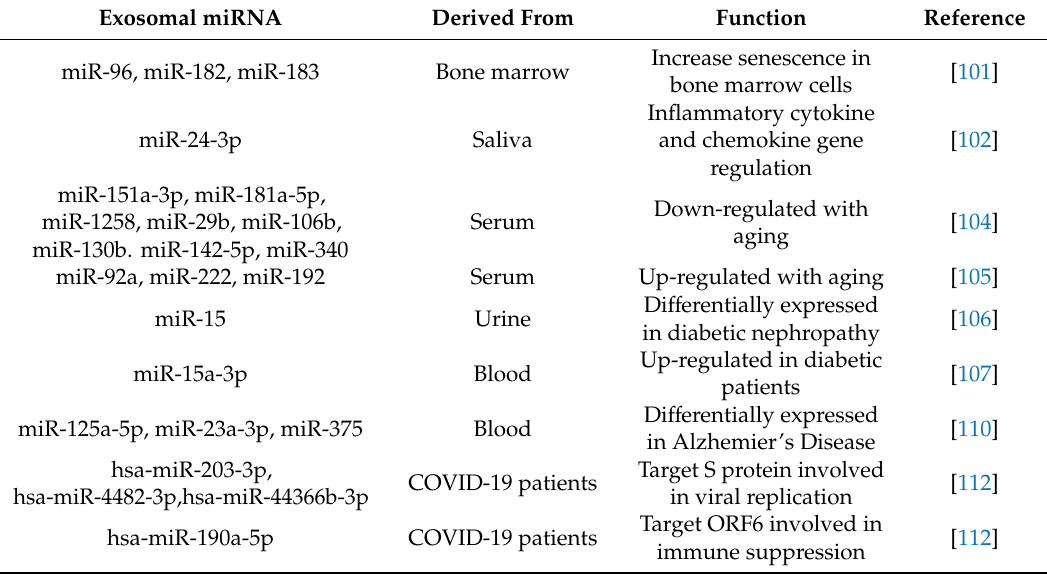
Table 2. Di ff erentially expressed exosomal miRNAs as biomarkers for